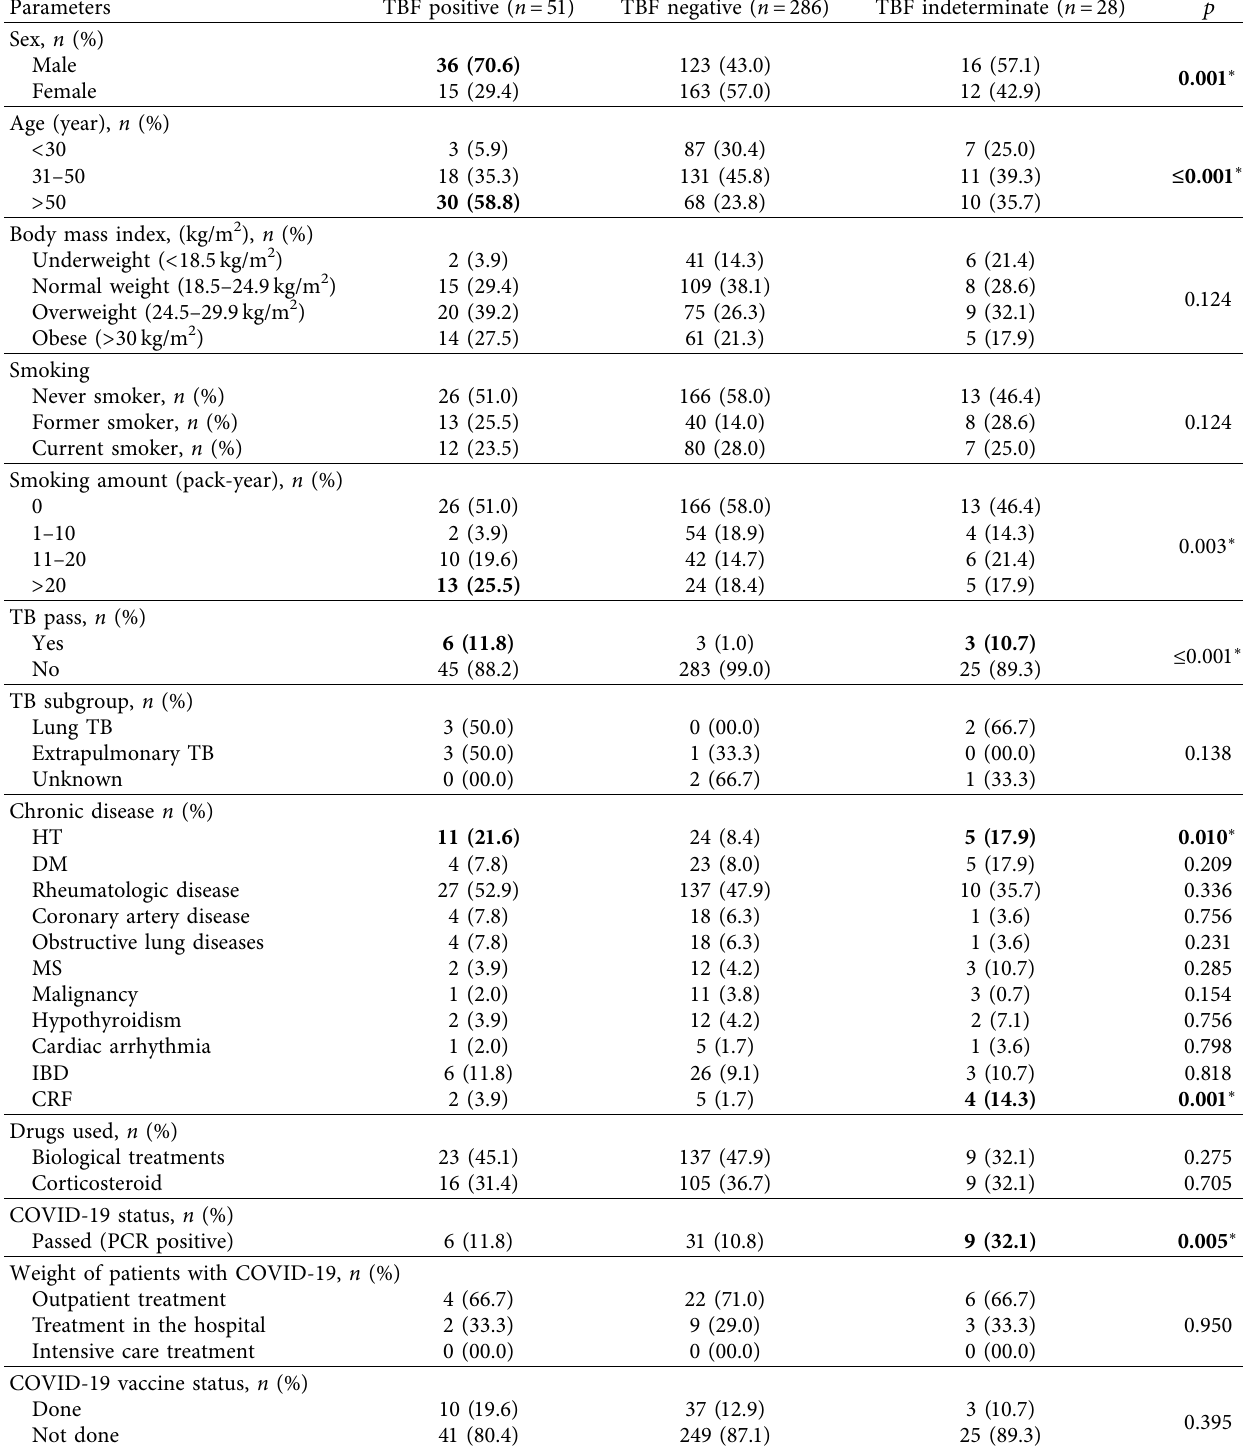
Table 3: Comparison of groups according to TBF test